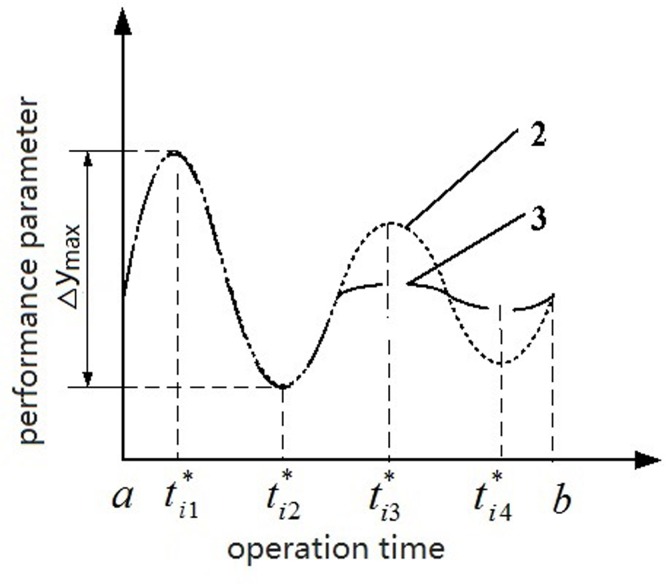
Diagram of performance parameter’s stability(b).